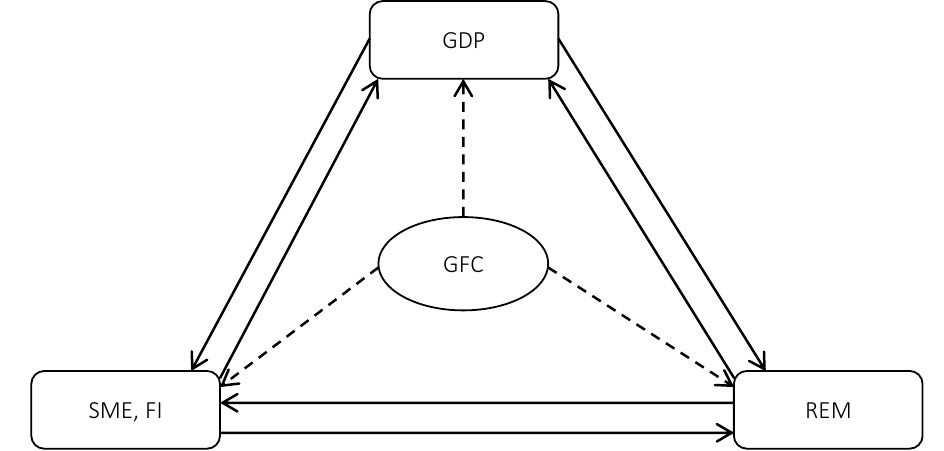
Figure 1. The correlation between stock market, real estate market, and economic